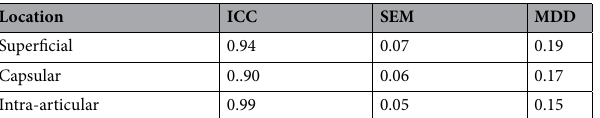
Table 1. Reliability of superficial, capsular and intra-articular temperature measurements. ICC Intra-class correlation coefficient, SEM Standard error of measurement, MDD Minimum detectable